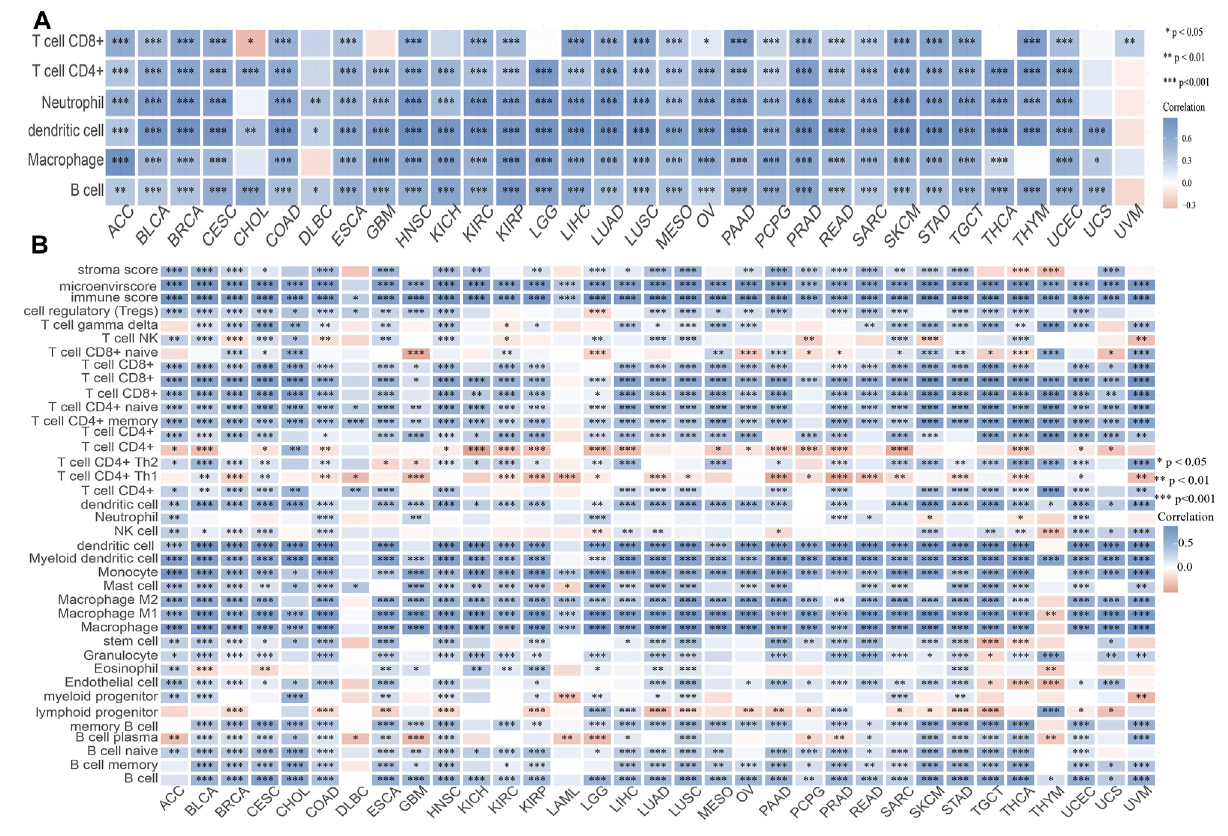
Frontiers in Cell and Developmental Biology |